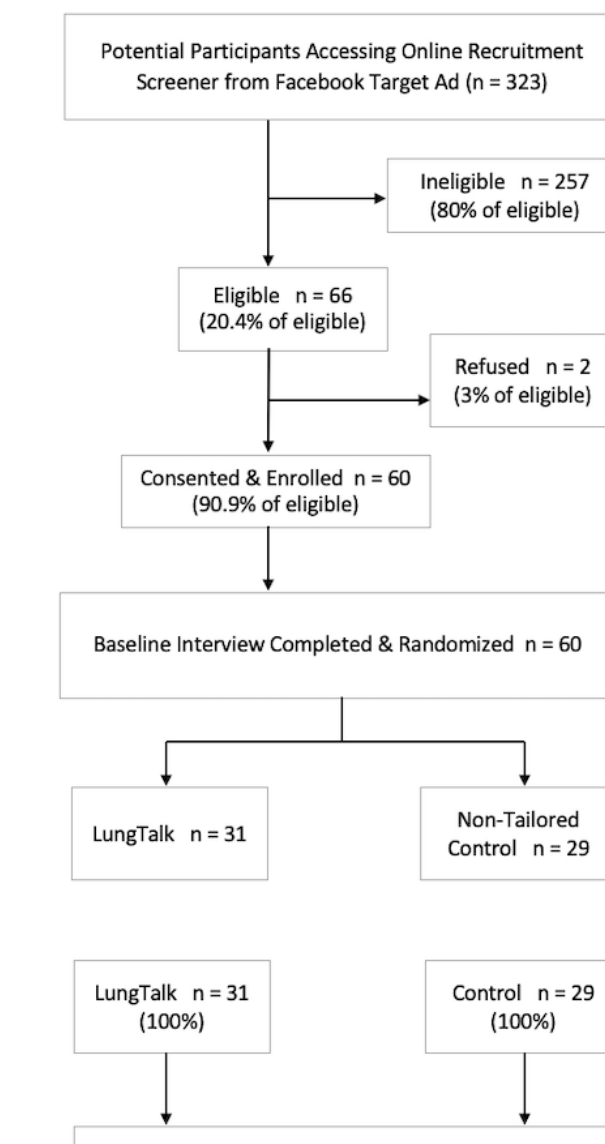
Figure 1. Participant recruitment